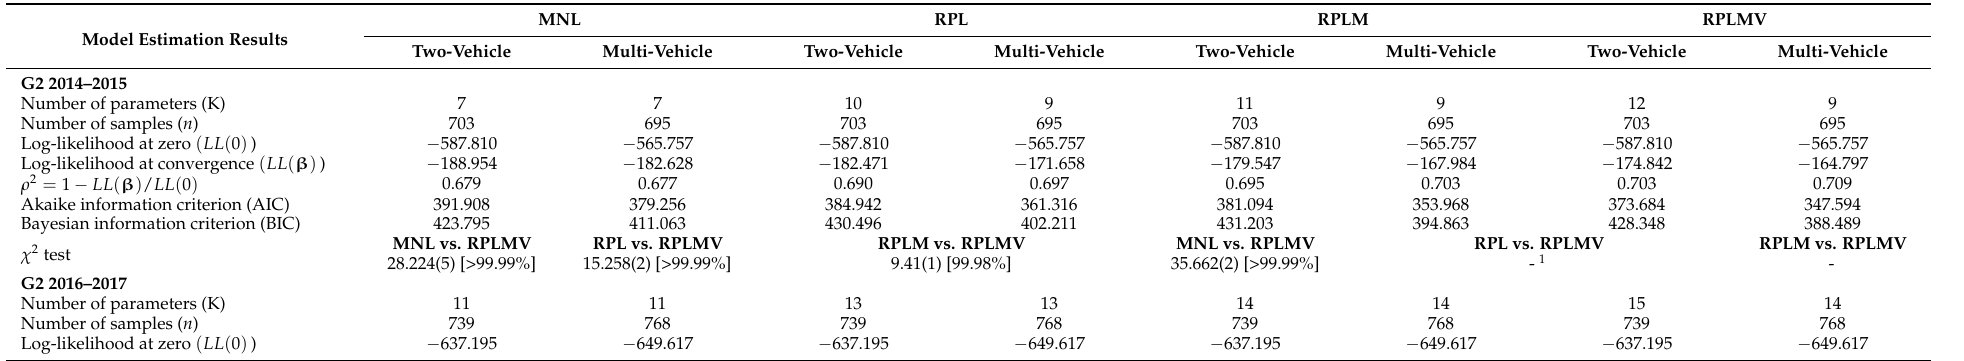
Table 3. Comparison of estimated